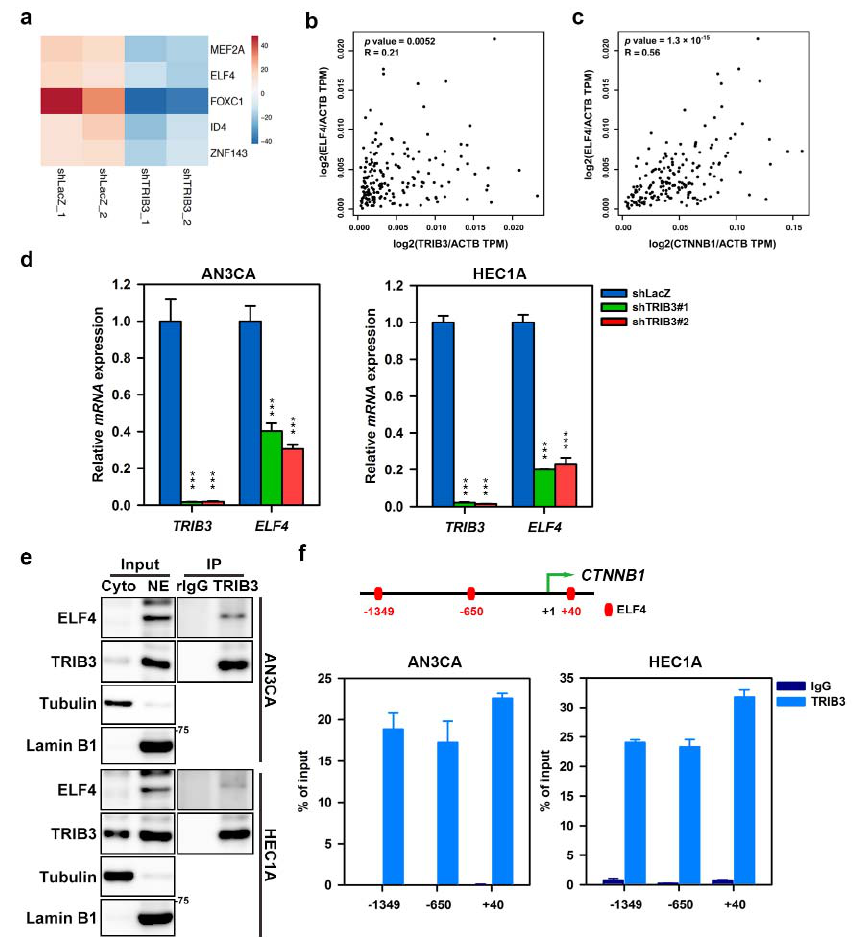
Figure 6. TRIB3 complexes with ELF4 in the nucleus of EC cells and binds to the CTNNB1 promoter. ( a ) The alterations of putative transcription factors of CTNNB1 promoter in TRIB3-knockdown HEC1A cells. The heatmap was drawn with the ClustVis web tool using the data from two independent replicates. ( b , c ) Pairwise correlations between TRIB3 and ELF4 ( b ) and between ELF4 and CTNNB1 ( c ) in UCEC dataset of TCGA were analyzed and plotted using the GEPIA website. ( d ) The mRNA expression of ELF4 in TRIB3-knockdown AN3CA (left panel) and HEC1A (right) cells was analyzed by SYBR-Green-based qRT-PCR. *** p < 0.001 when compared to shLacZ group. ( e ) AN3CA and HEC1A cells were pretreated with 2 µ M MG132 for 18 h. Then, 200 µ g of nuclear extract was used for immunoprecipitation with an anti-TRIB3 antibody or normal rabbit IgG (rIgG) followed by Western blot analysis of ELF4 and TRIB3 expression. Ctyo, cytosolic fraction; NE, nuclear extract. ( f ) The chromatins of AN3CA or HEC1A cells were cross-linked, sonicated into fragments, incubated with 3 µ g of anti-TRIB3 antibody (TRIB3) or normal rabbit IgG (IgG), and precipitated with Protein-G-conjugated magnetic beads. The DNA fragments of CTNNB1 promoter containing the putative ELF4 binding motif (red bars in upper panel) were detected using the qPCR method with three specific primer